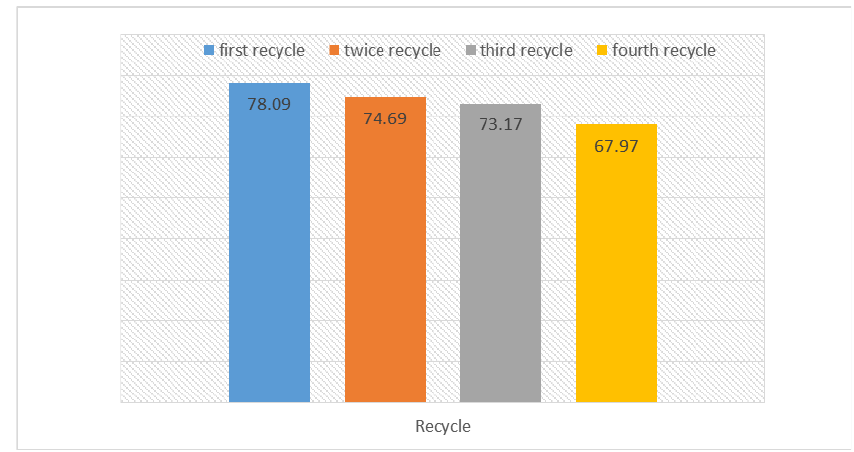
Figure 2. The recycle test results for regenerated 5 wt.% Pd(OH) 2 /C catalyst.